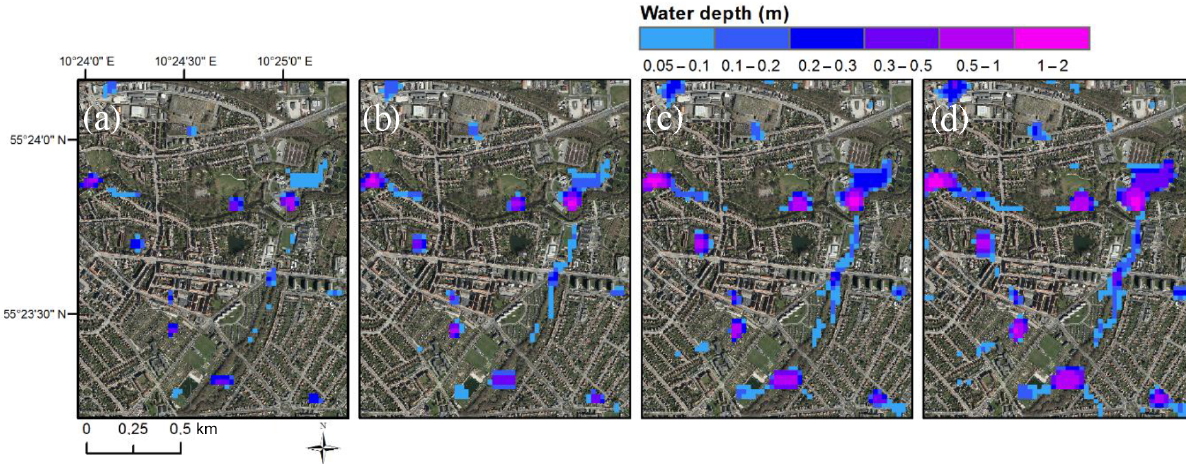
Figure 6. Flood-hazard maps for sub-area in Odense showing the maximum water depth and extent during extreme precipitation events with return periods of (a) 10, (b) 20, (c) 50 and (d) 100 years for RCP 8.5 in the period 2081–2100 using average climate factors and present-day